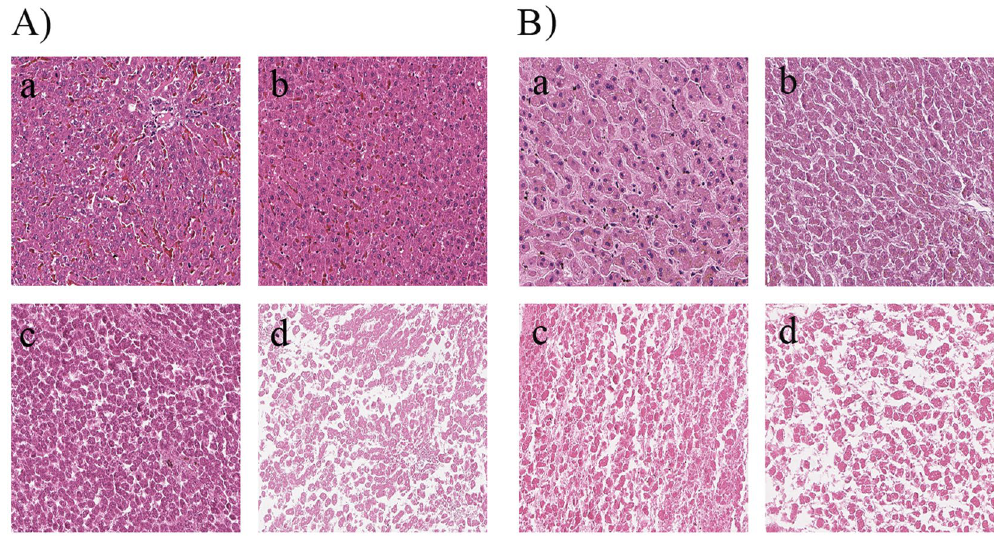
Figure 1. Histological changes at (a) 0, (b) 48, (c) 96, and (d) 144 h postmortem for liver tissues. ( A ) in SD rat liver samples; ( B ) in human liver samples.